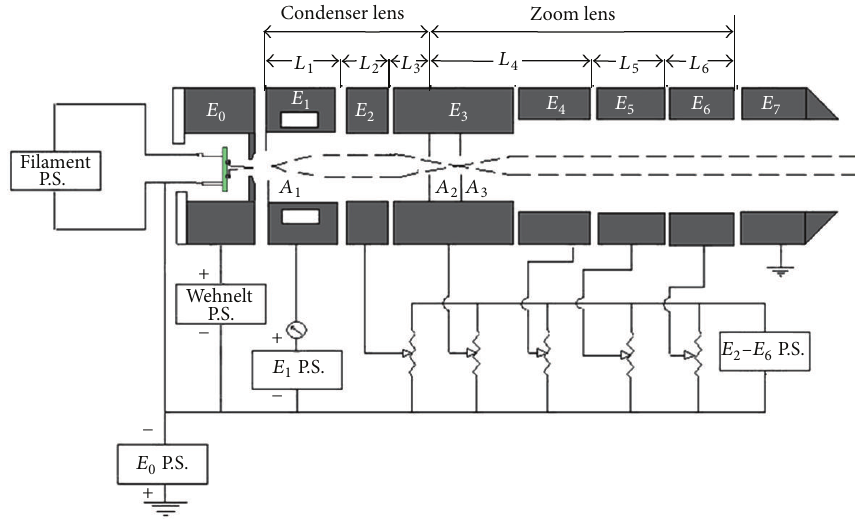
Figure 3: The schematic diagram of the electron gun with an electrical circuit.